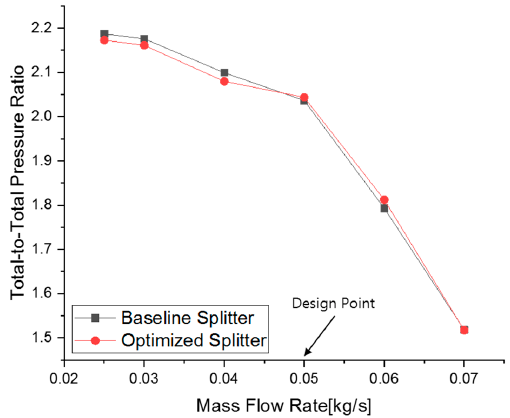
Figure 22. Total-to-total pressure comparison between the optimal and baseline splitters.